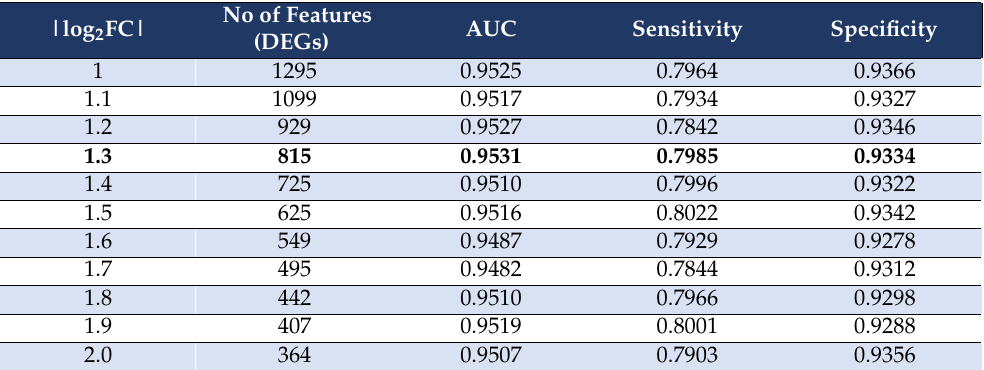
Table 2. Performance parameters of the various classification models for the different set of DEGs. Bold: the one with the highest